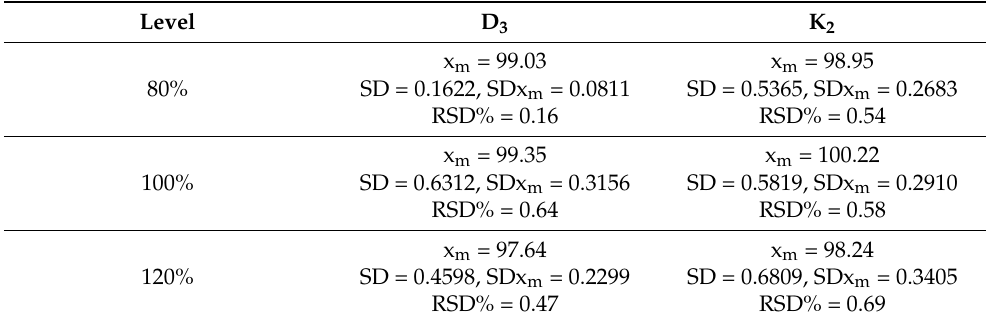
Table 2. Recovery values determined for vitamins D 3 and K 2 with statistical evaluation.